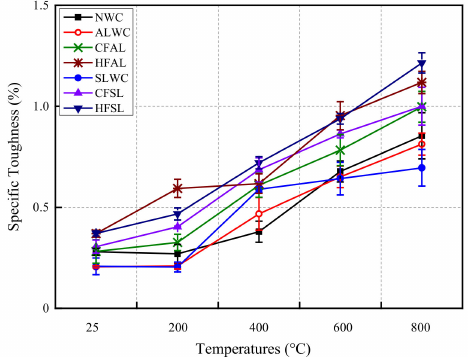
Figure 13. Effect of temperature on the specific toughness of different